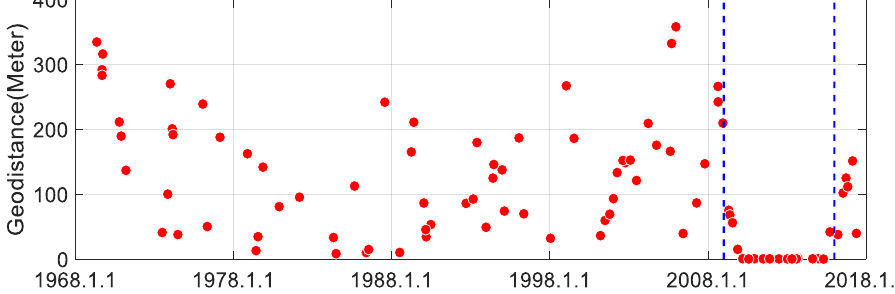
Figure 6. Geo-distances between the calculated results without aberration and light time correction and the estimated results of the satellite tool kit (STK).